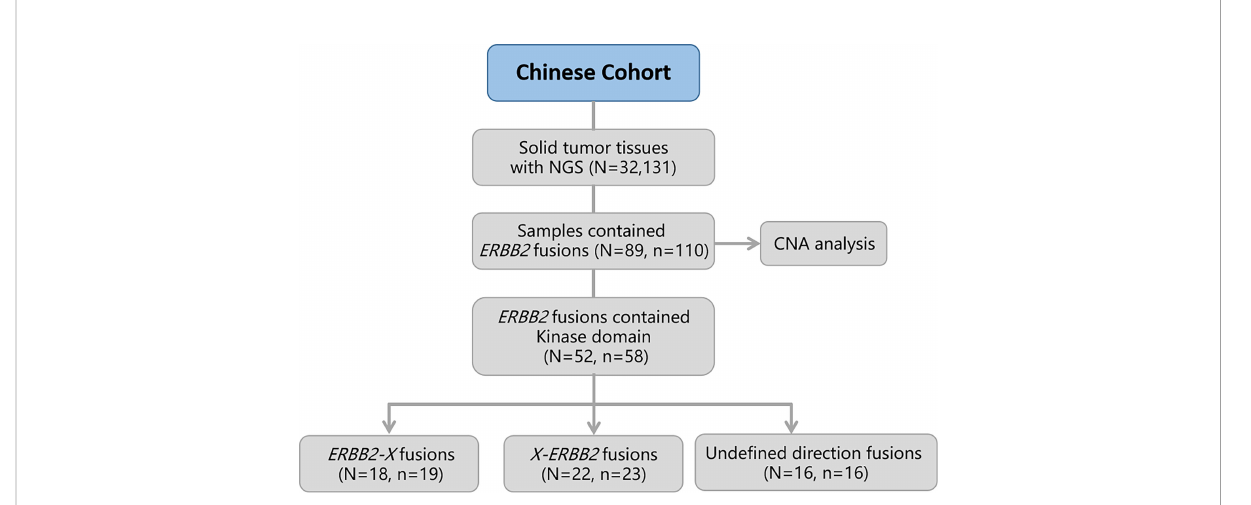
FIGURE 1 Flow diagram of the study. OS, overall survival; CNA, copy number alteration. N, number of patients; n, number of ERBB2